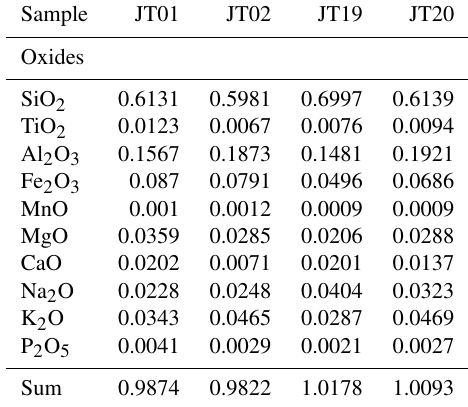
Table B1. Excerpt of XRF data for four samples. Data in column denote weight percentages of major oxides within the rock